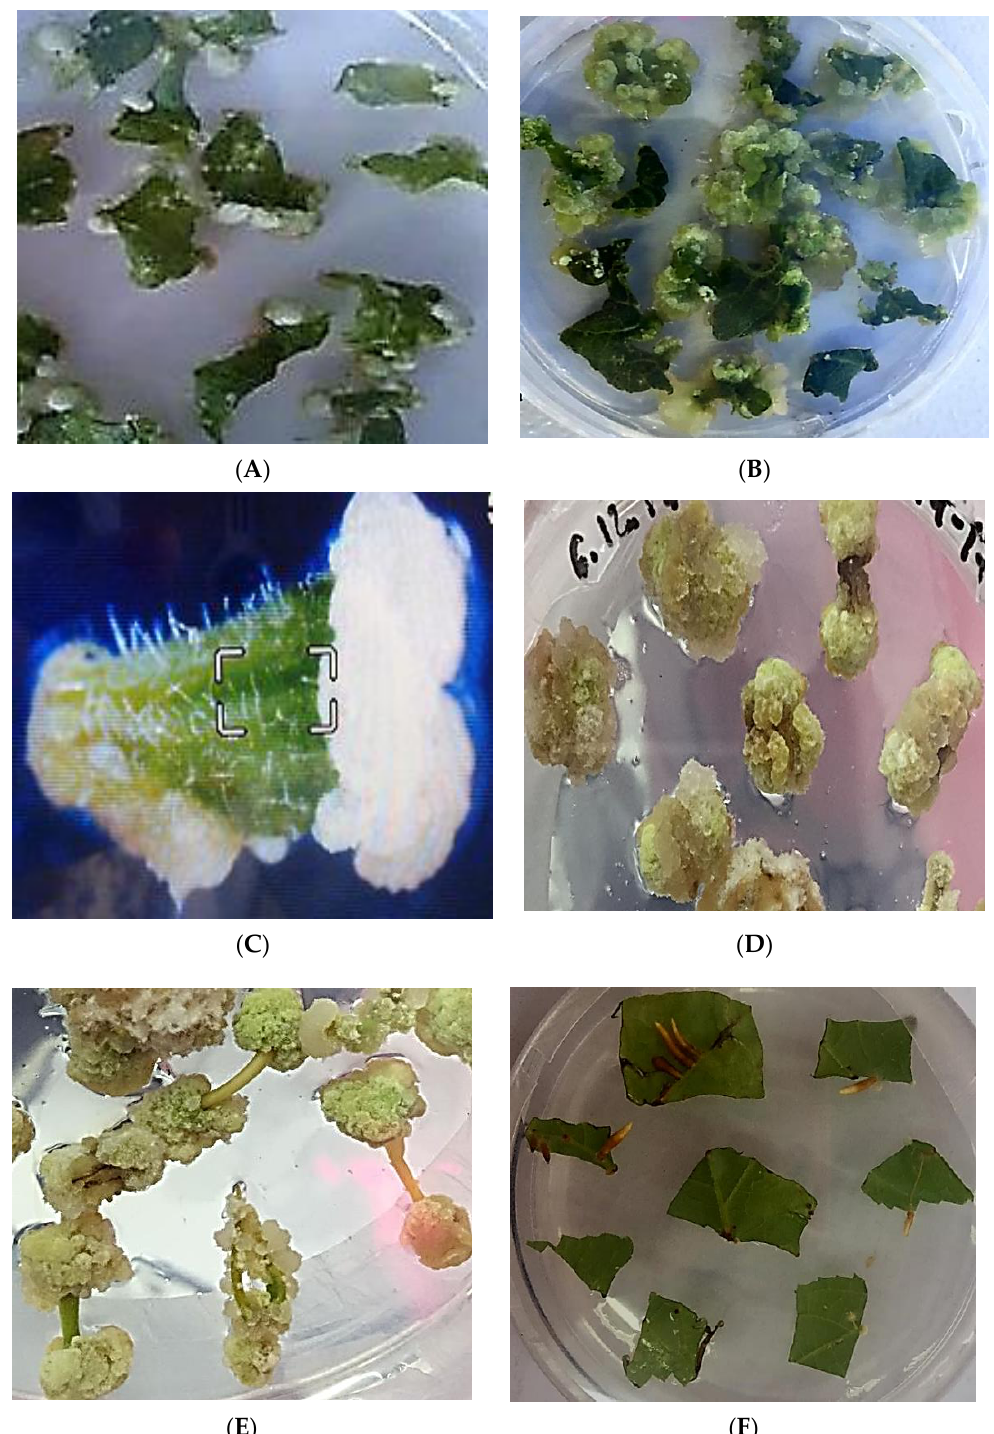
Figure 1. Induction of callus tissues from different explants of Paulownia tomentosa on MS2 media: morphology of white callus tissues from leaves ( A,B ), internodes ( C ), nodes ( D ), and petals ( E ); root formation directly (organogenesis) from the explants of leaf on MS media with 13.9 µM kinetin + 2.8 µM IAA ( F ).